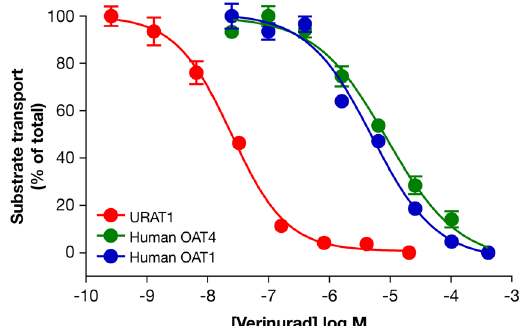
Figure 1. Verinurad is highly potent and specific for human URAT1. Dose-responses for verinurad against the transport activity of human URAT1 (red), human OAT4 (green) and human OAT1 (blue). Cells expressing URAT1 were incubated with 14 C-uric acid, and cells expressing OAT4 or OAT1 were incubated with carboxyfluorescein, in the presence of different amounts of verinurad. Data are from one representative experiment presented as the mean ± SEM of samples measured in triplicate.